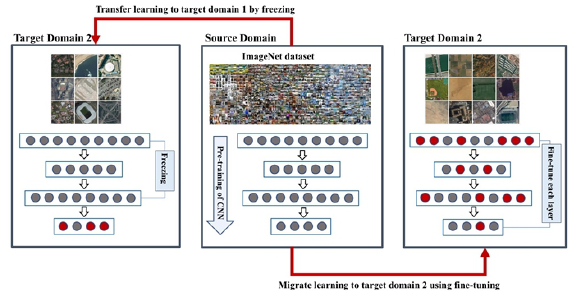
Figure 2. Freezing and Fine-Tuning in Transfer Learning